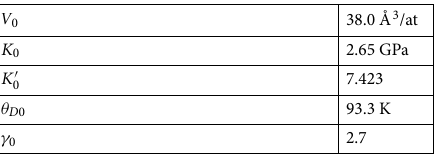
Table 2. Parameters of Mie–Grüneisen–Debye quasi-hydrostatic equation of state for fcc argon. Subscript 0 indicates reference state, at ambient pressure and 0 K.